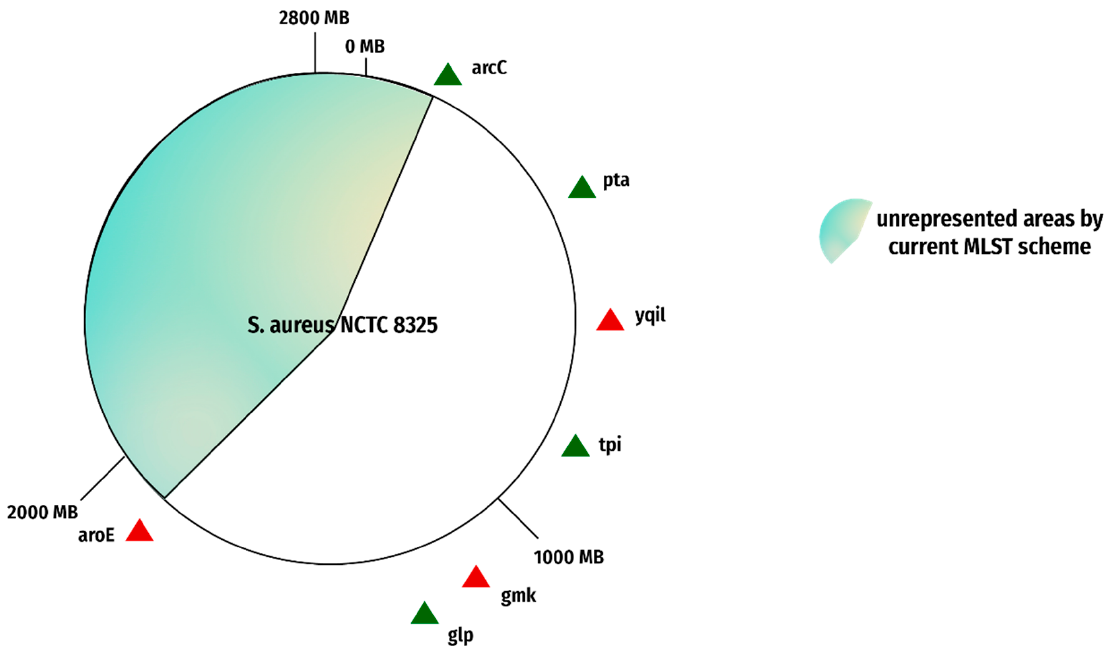
Figure 6. Reported flaws in MLST genes. The figure represents the genes of the current MLST scheme on reference genome NCTC 8325. The red triangles show the genes with reported flaws. The green triangles show the genes with no reported shortcomings.